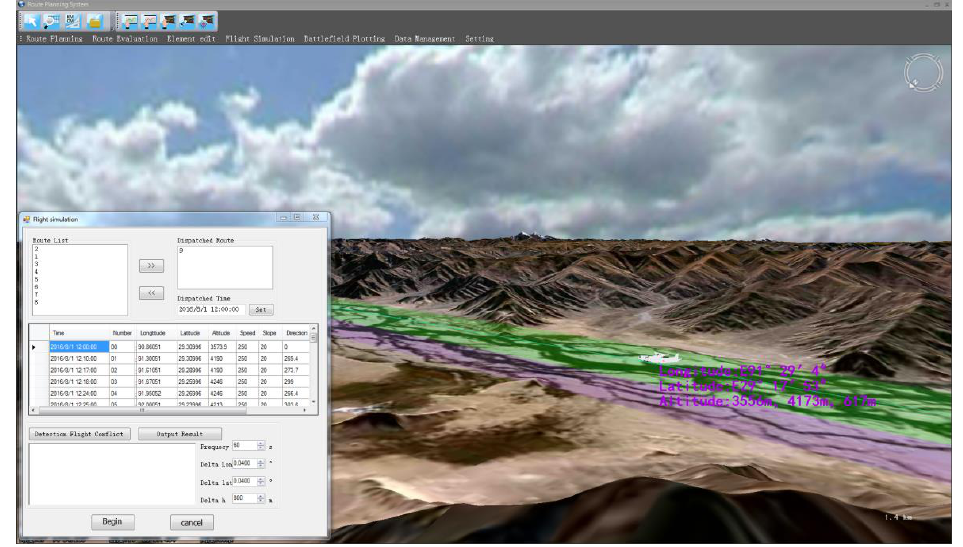
Figure A2. Screenshot of a flight simulation in the route planning system in which a simulated flight experiment is performed for the saved route.